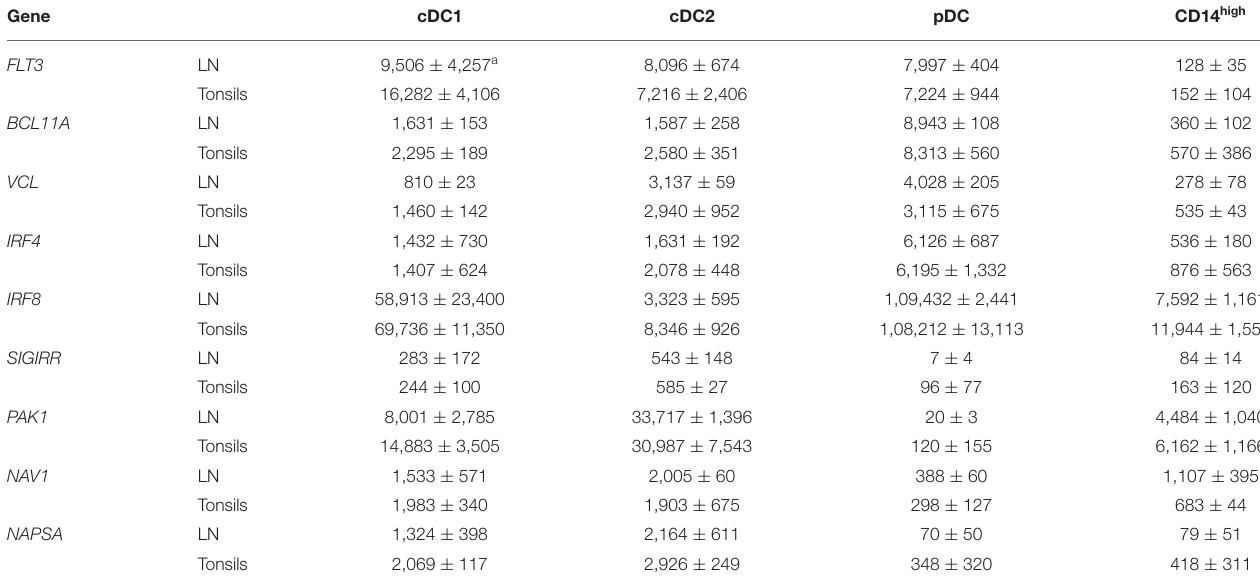
TABLE 1 | cDC-specific and DC-specific differentially regulated genes.